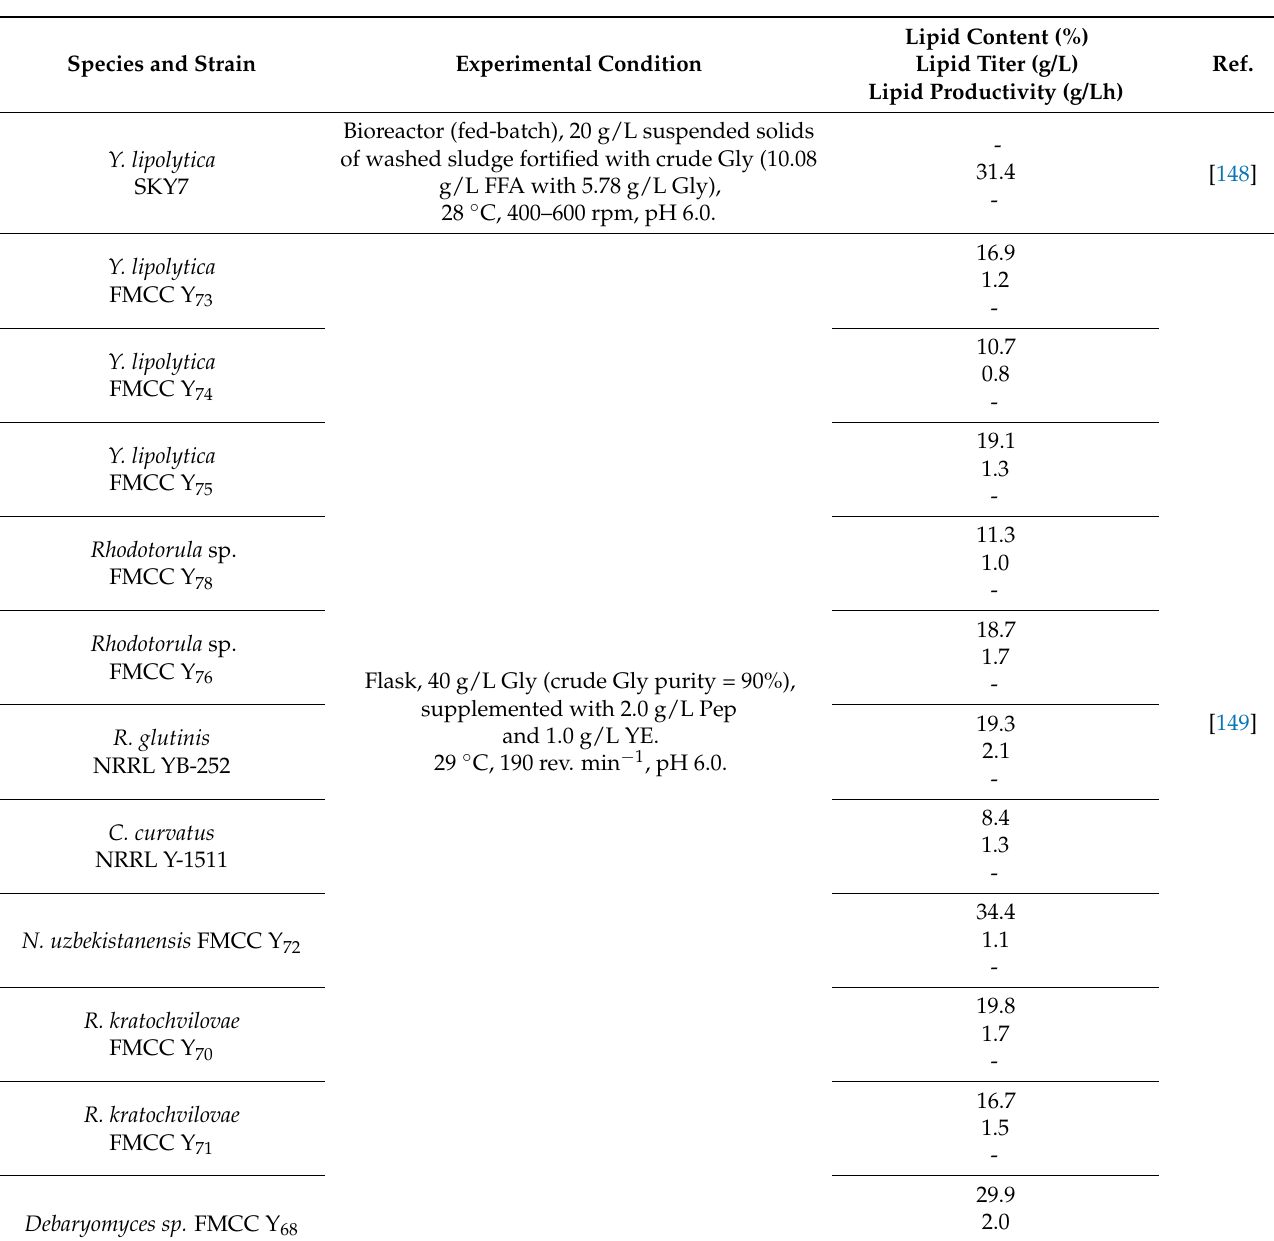
Table 4. Lipid production by Cryptococcus curvatus , Naganishia uzbekistanensis , Rhodotorula glutinis , Rhodotorula kratochvilovae , Rhodotorula toruloides , Trichosporon fermentans , Trichosporon oleaginosus and Yarrowia lipolytica using crude glycerol as